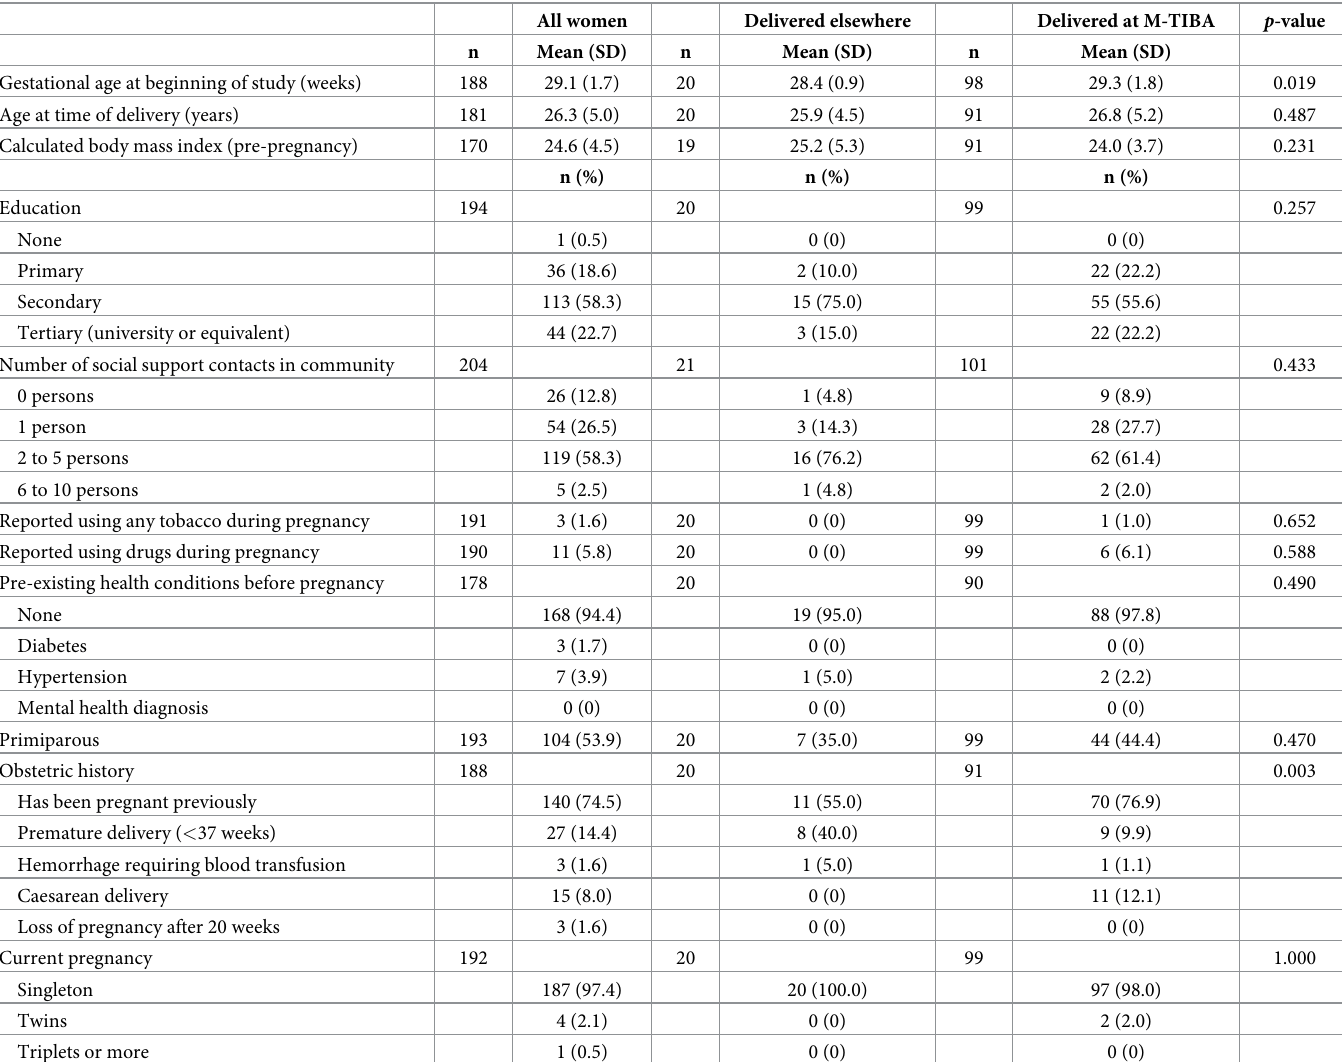
Table 1. Patient-reported baseline